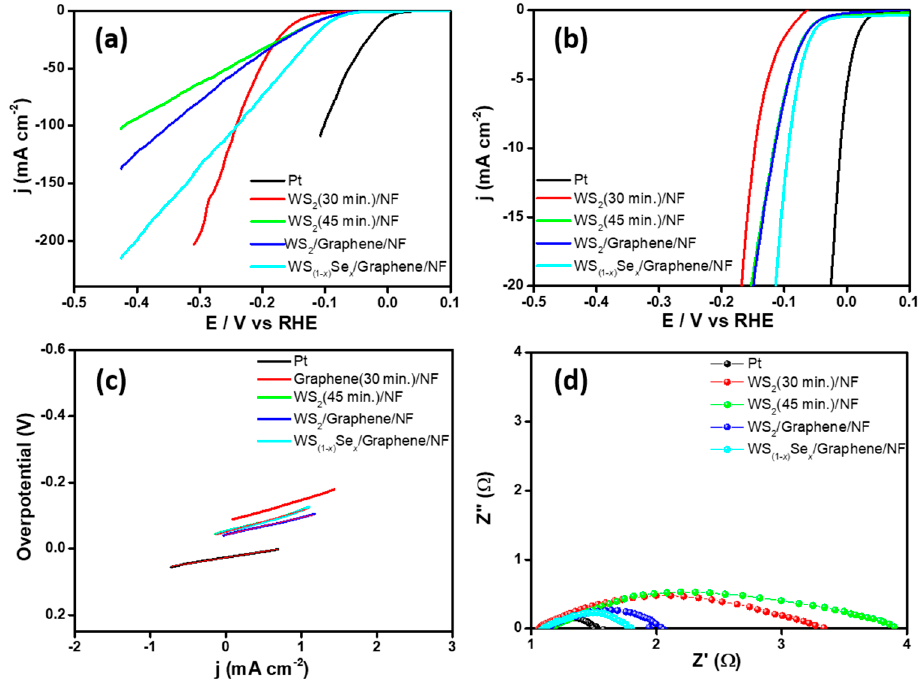
Figure 6. Electrochemical performance of different electrocatalysts. ( a , b ) Linear sweep voltammetry (LSV) curves of Pt, WS 2 (45 min)/NF, WS 2 /graphene/NF and WS (1 − x ) Se x /graphene/NF electrocatalyst with scan rate @ 10 mV s − 1 ; ( c ) corresponding Tafel plots obtained from the LSV curves; ( d ) EIS spectra for Pt, WS 2 (45 min)/NF, WS 2 /graphene/NF and WS (1 − x ) Se x /graphene/NF electrocatalyst.